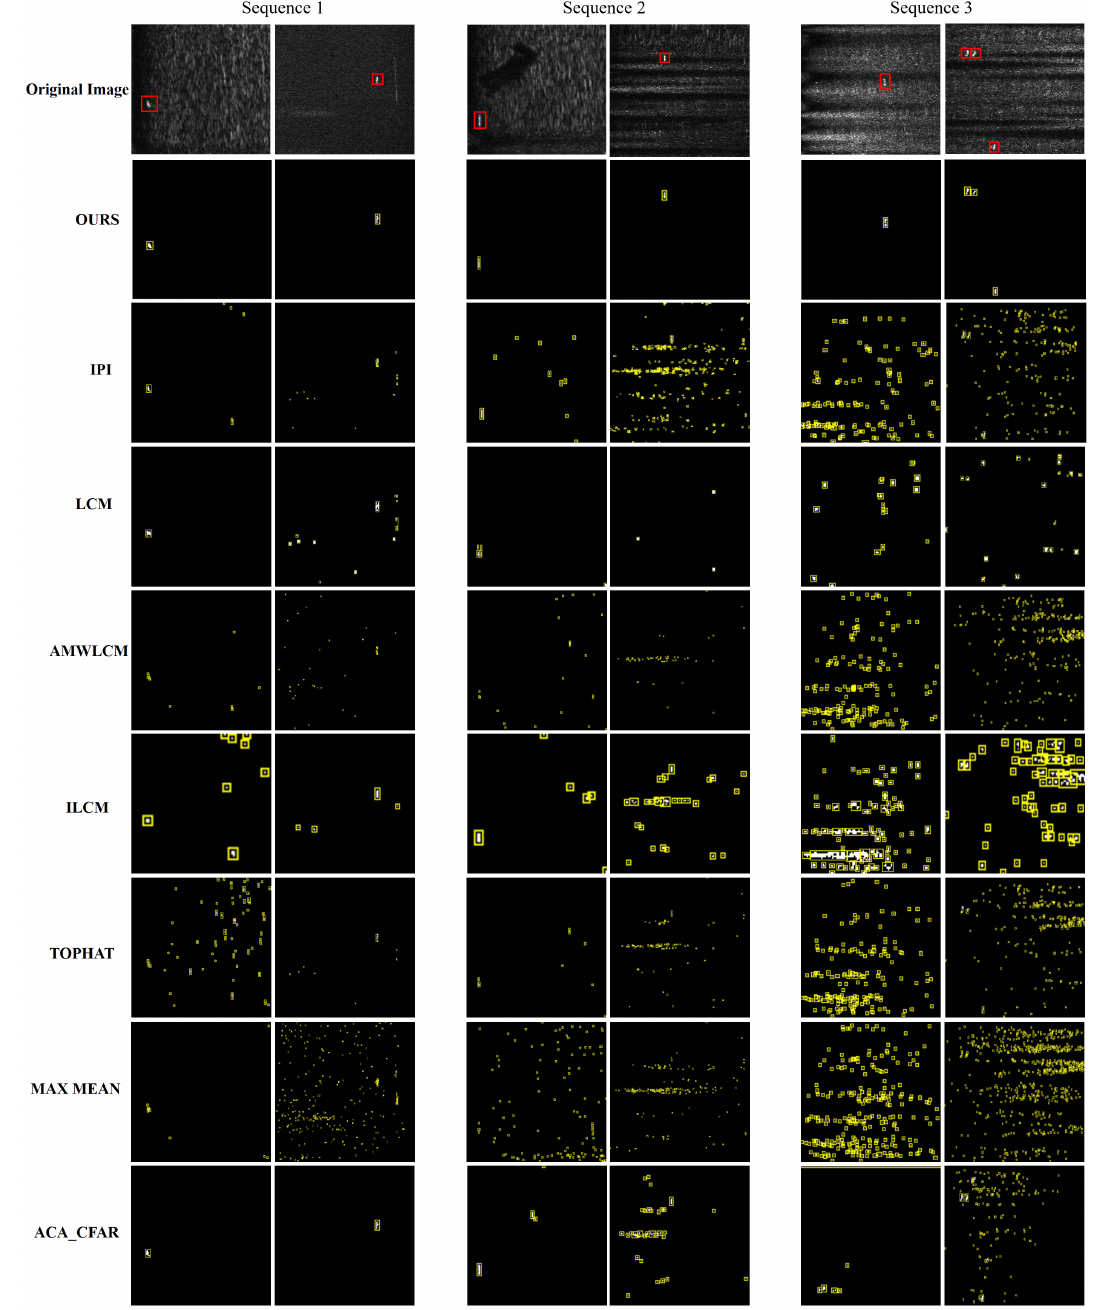
Figure 11. Visualization result of different algorithms in three sequences. The red rectangular box is the ground truth and the yellow rectangular box is the detection